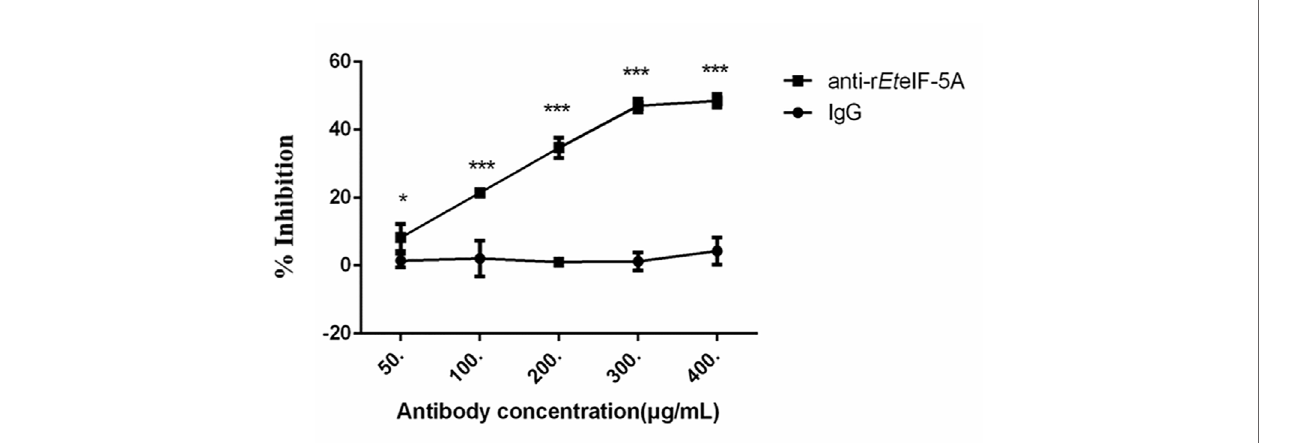
FIGURE 10 | Inhibition of host cell invasion in vitro using anti-r Et eIF-5A antibody. Anti-r Et eIF-5A, rabbit anti-r Et eIF-5A IgG antibody; IgG, pre-immune rabbit serum. All assays were performed in triplicate. In fi gures, signi fi cant differences (p < 0.01) between groups are indicated by different numbers of ‘ * ’ . Highly signi fi cant differences (p < 0.001) between groups are indicated by different numbers of ‘ *** ’